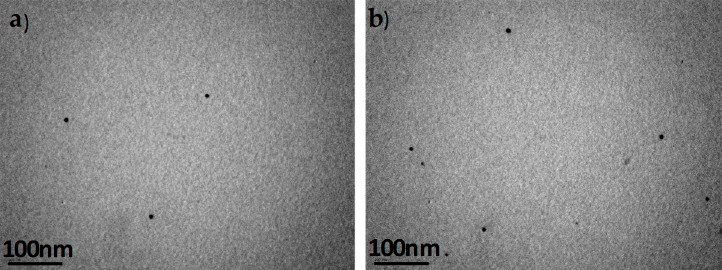
Figure 7. TEM images of a PCDTBT:PC 71 BM 1:1 w/w ( a ) before and ( b ) after annealing at 80 °C. The scale bars correspond to 100 nm.